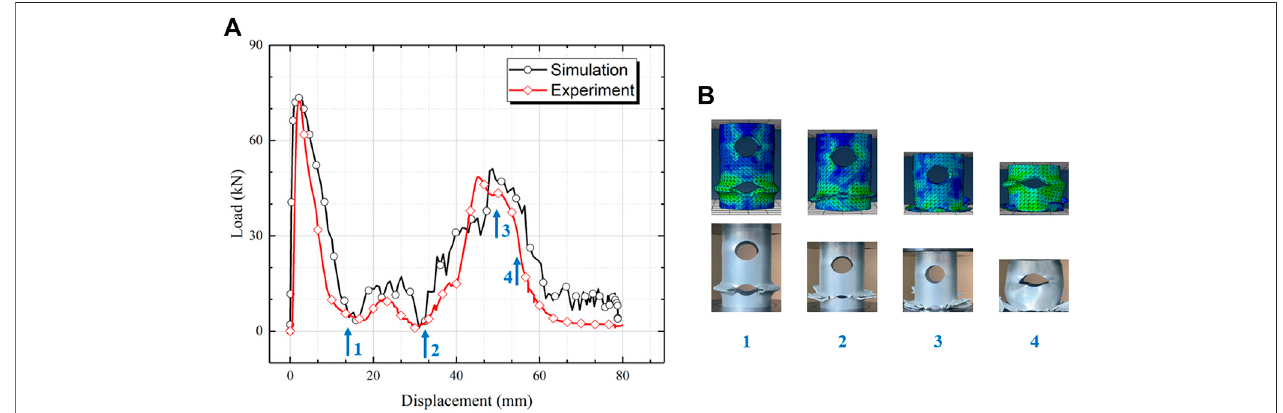
FIGURE 10 | Comparison of simulation and experimental results in (A) the load – displacement curve and (B) deformation modes.